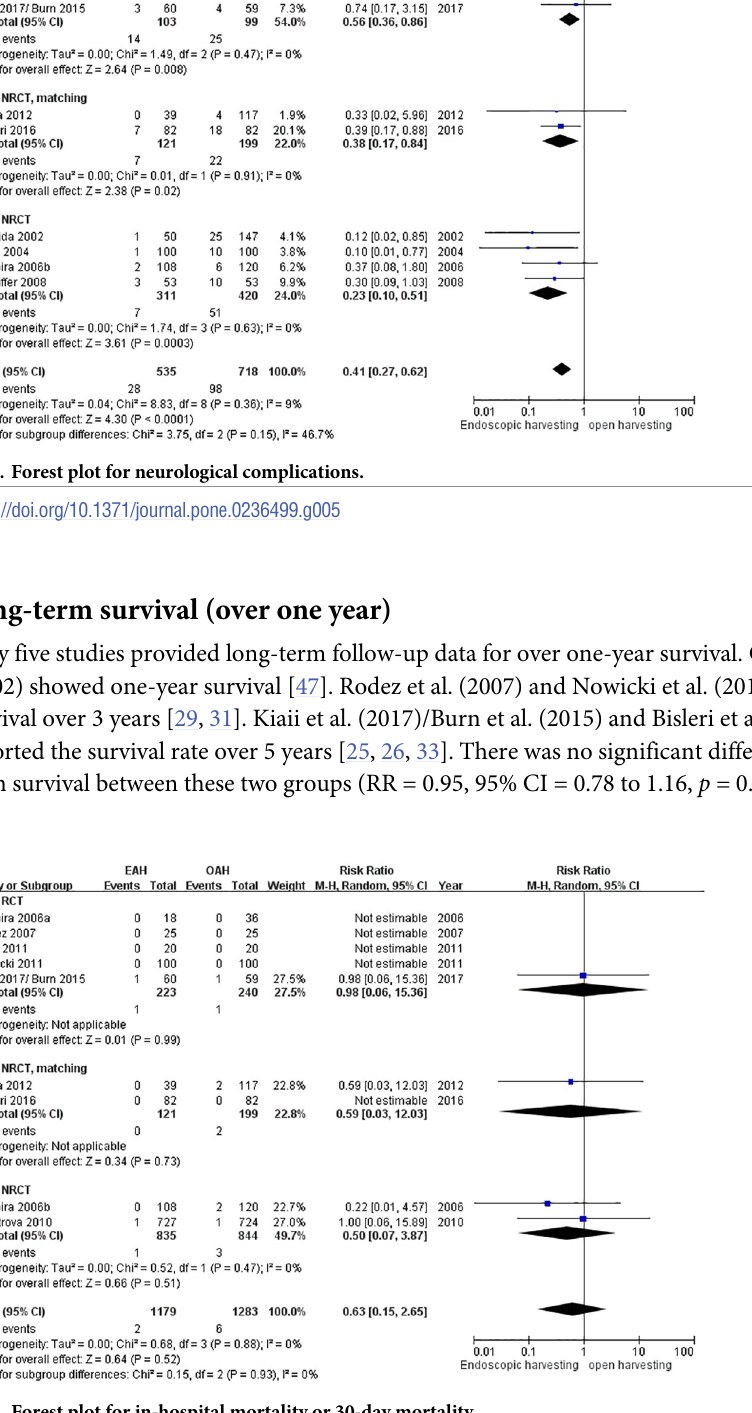
Fig 6. Forest plot for in-hospital mortality or 30-day